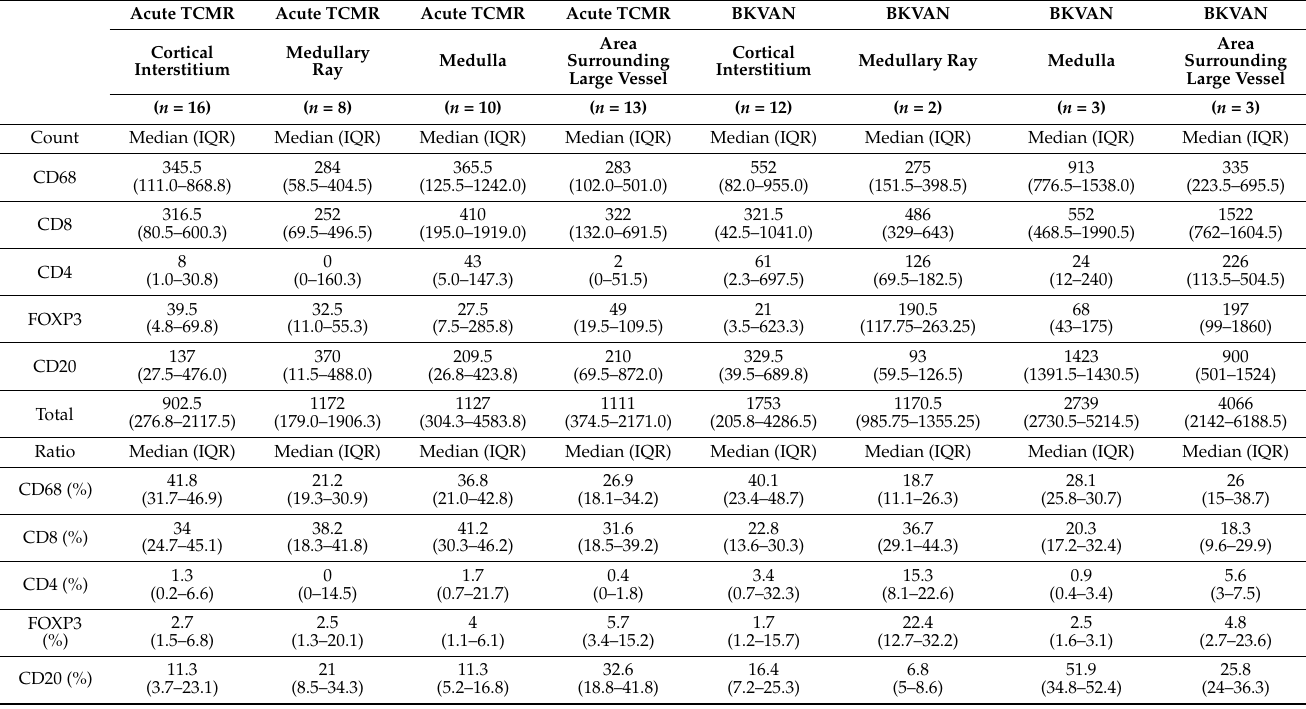
Table 3. Median mononuclear cell subset numbers and ratios counted in regions of interest (ROI) and assessed using five monoclonal antibodies in nine cases of acute T-cell-mediated rejection (Acute TCMR) and five cases of BK virus-associated nephropathy